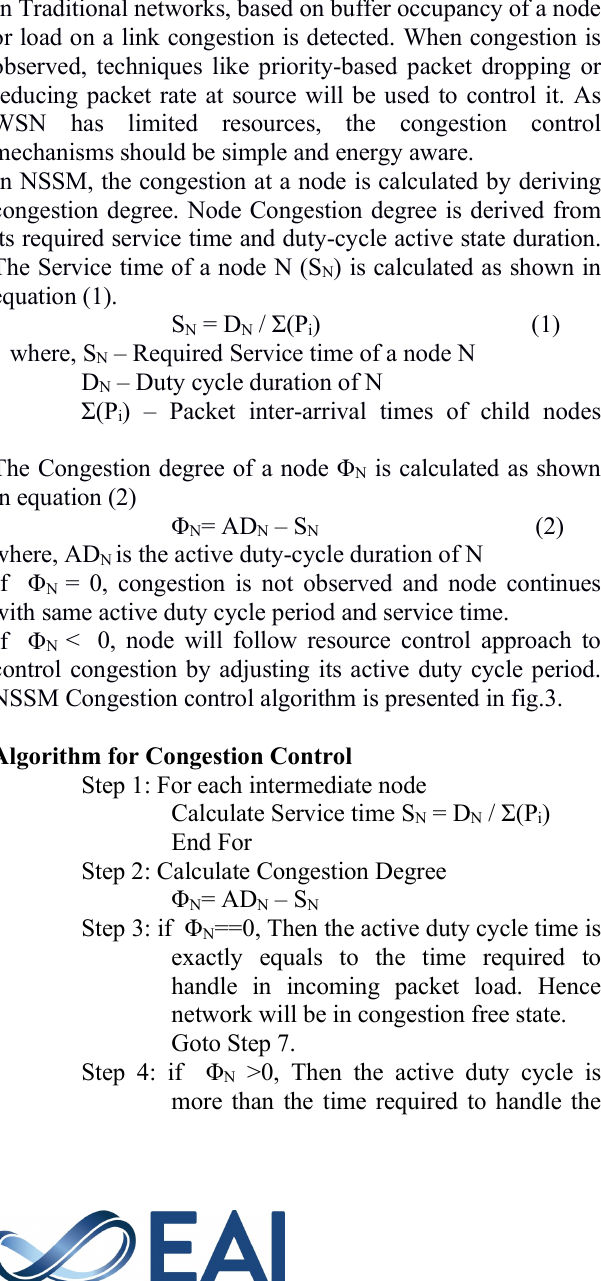
Figure 3. Congestion Control Algorithm